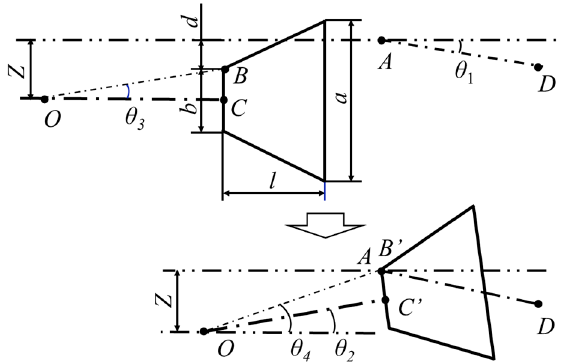
Figure 17. The connecting process of the guiding mechanism and the fastening bolt.